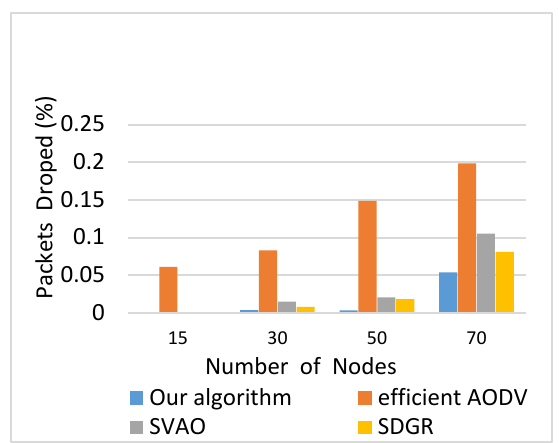
Figure 8. Packet drop ratio.